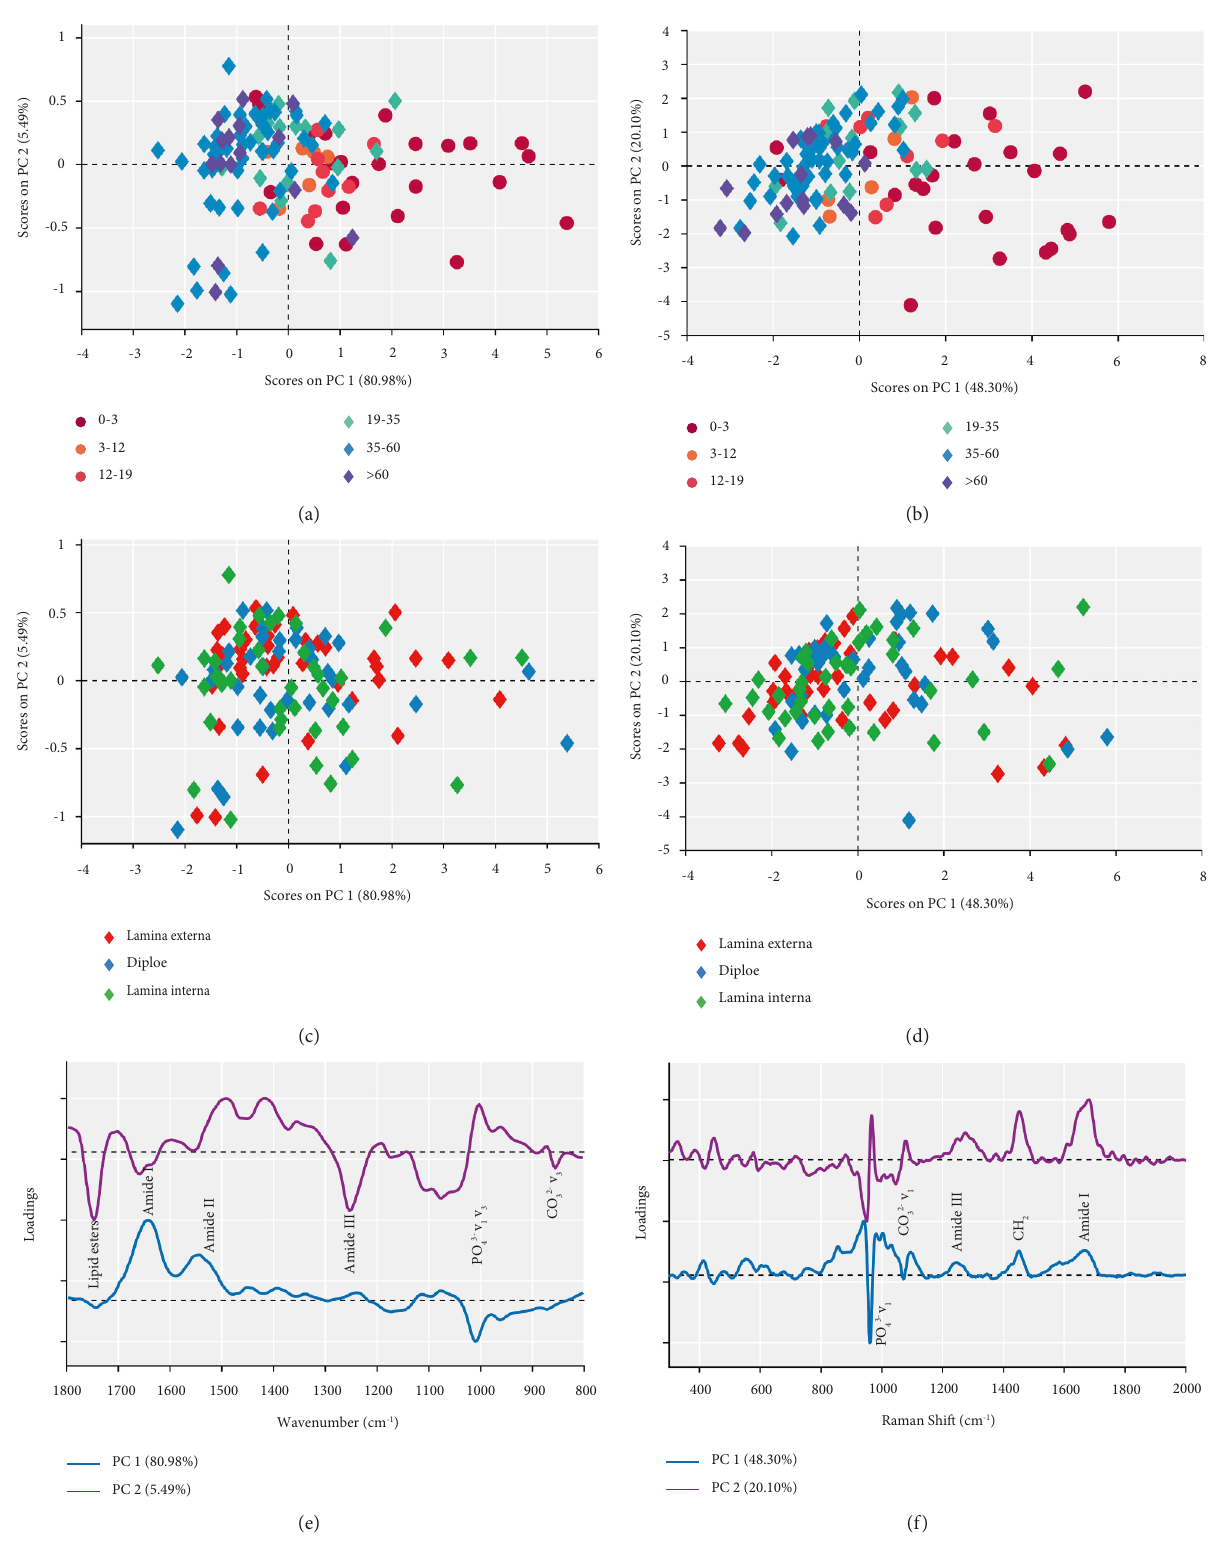
Figure 3: The PCA results of FTIR and Raman. (a) FTIR PCA score plot for 6 age stages. (b) Raman PCA score plot for 6 age stages. (c) FTIR PCA score plot for 3 structures (lamina externa, diploe, and lamina interna). (d) Raman PCA score plot for 3 structures (lamina externa, diploe, and lamina interna). (e) FTIR PC1 and PC2 loading plot. (f) Raman PC1 and PC2 loading